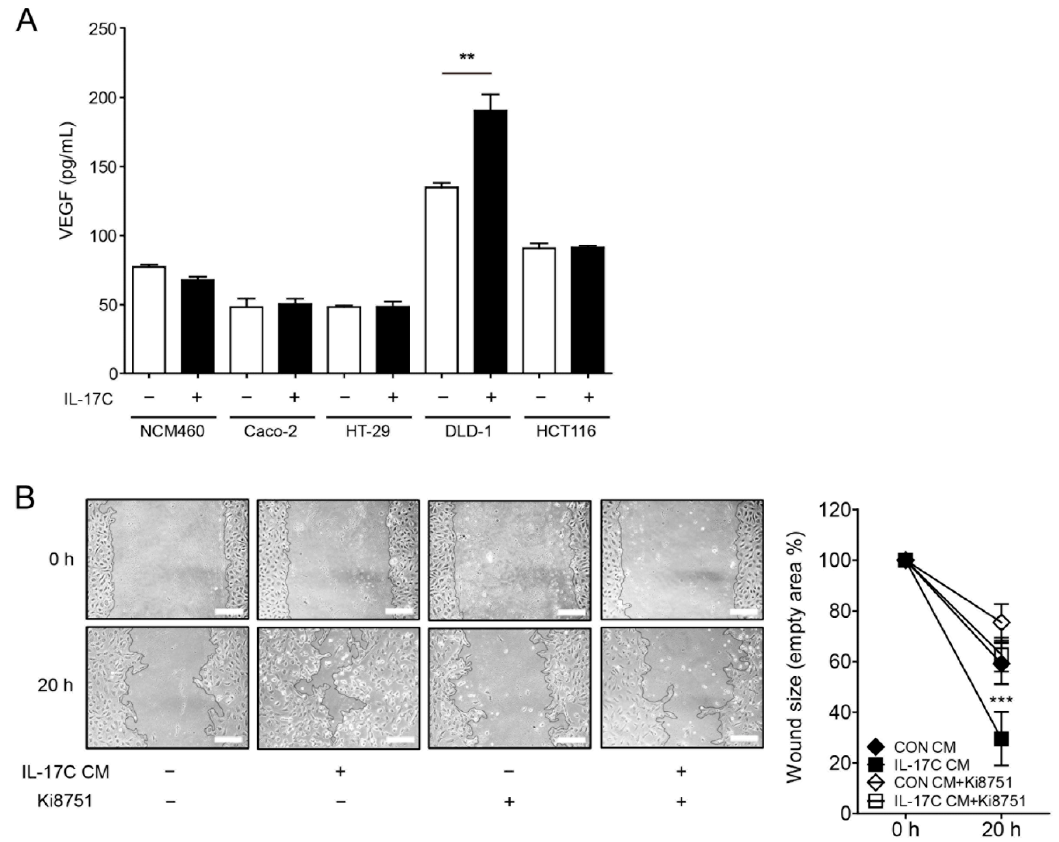
Figure 3. IL-17C-induced cell migration is mediated by VEGF and suppressed by the VEGFR2 inhibitor Ki8751. ( A ) Human VEGF concentration was calculated in IL-17C (100 ng / mL, 8 h)-treated CM from NCM460, Caco-2, HT-29, DLD-1, and HCT116 cells by using ELISA. Error bars, SD ( n = 3). ** p < 0.01 vs. the DLD-1 control group. ( B ) HIMECs were pretreated of Ki8751 (4.7 µ g / mL) for 30 min, scratched, and incubated in CM from IL-17C (100 ng / mL)-stimulated DLD-1 cells for 20 h (( B ), left ). Scale bar, 50 µ m. Representative fields from photos of the wound healing assays, analyzed using ImageJ v.1.47 software (( B ), right ). Error bars, SD ( n = 6). *** p < 0.001 vs. the control CM group.